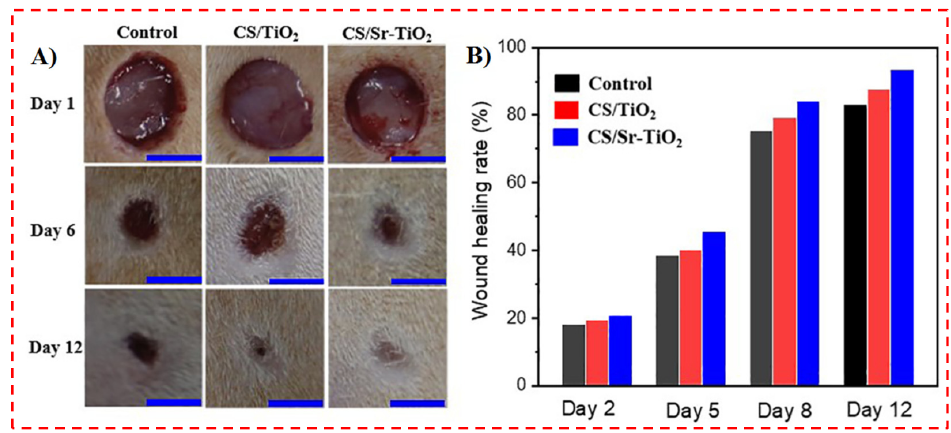
Figure 6. ( A ) In vivo evaluation of control, chitosan (CS)/titanium dioxide (TiO 2 ), and CS/Sr-TiO 2 nanocomposite as wound dressing, scale bar: 5 mm, and corresponding wound healing rate ( B ) [102].